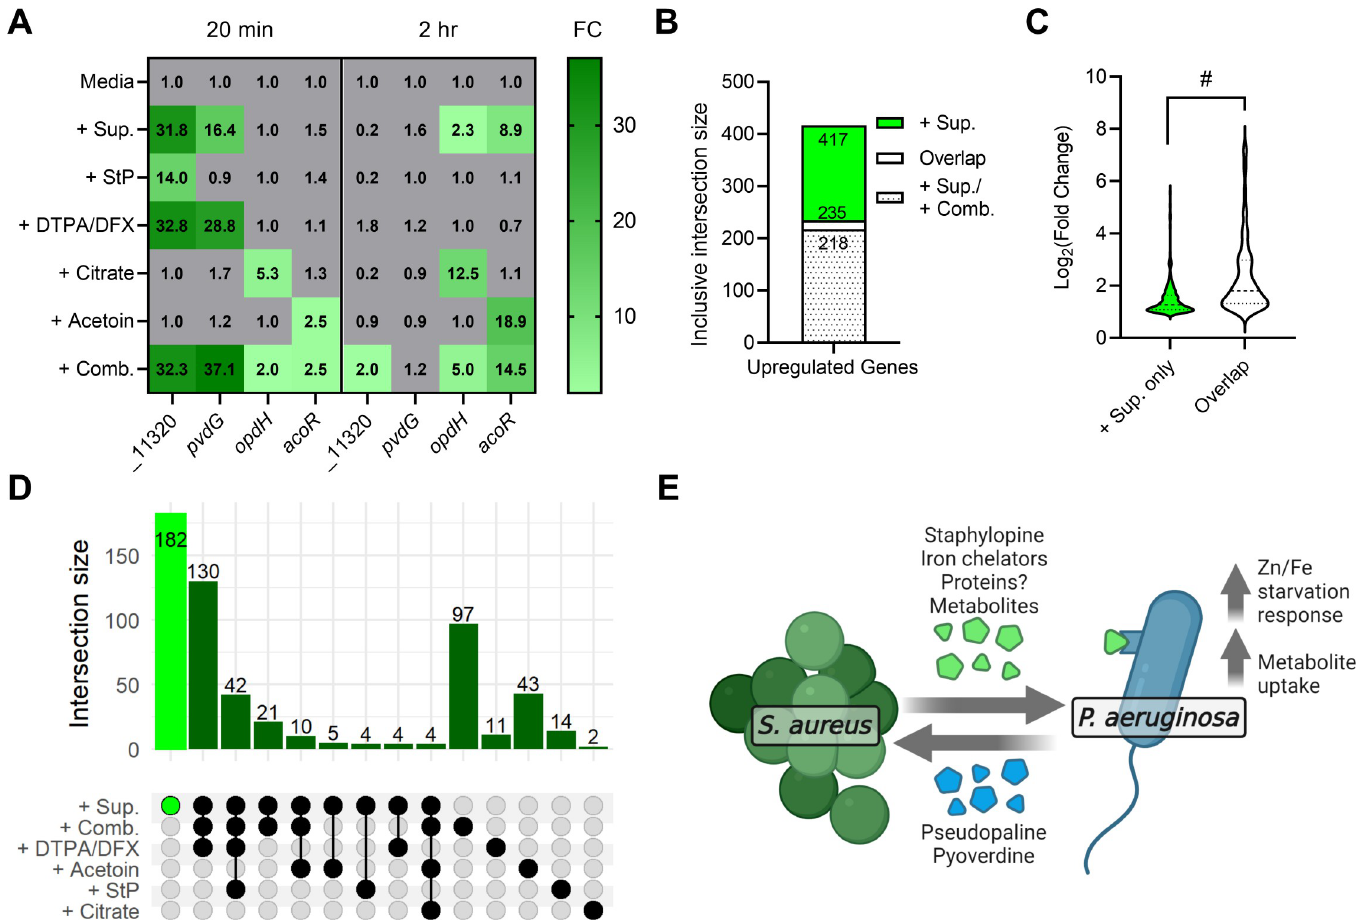
Fig 8. Identified sensed products recapitulate a major part of the P . aeruginosa response to S . aureus supernatant. (A) Heatmap of fold change of the transcripts PA14_11320, pvdG , opdH , and acoR after addition of S . aureus supernatant, the indicated molecules, or all molecules in combination (+ Comb.) over media control, after 20 minutes or 2 hours. (B) Inclusive intersection of all up-regulated genes after addition of supernatant (+ Sup.) versus at least one other condition (Overlap) or the combination of all molecules (+ Sup. / + Comb.). (C) Log 2 fold change of the up-regulated genes that are nonintersecting (+ Sup. only) or intersecting among supernatant and at least one other condition (Overlap). Medians (dashed lines) and first/third quartiles (dotted lines) are shown. Datasets were analyzed by a 2-tailed t test. #, p < 0.0001. (D) UpSet plot of exclusive intersections of up-regulated genes between addition of S . aureus supernatant and the indicated molecules. (See S8 Fig for full UpSet plot of all intersections.) (E) Model of P . aeruginosa sensing of S . aureus exoproducts. S . aureus secretes StP, iron chelators, intermediate metabolites, and possibly proteinaceous molecules that are sensed by P . aeruginosa . In response, P . aeruginosa up-regulates metal starvation and metabolite uptake pathways, which includes production of its own metal-binding molecules PsP and pyoverdine. The data underlying panels ABD and C can be found in Table M in S1 File and S1 Table, respectively. PsP, pseudopaline; StP,